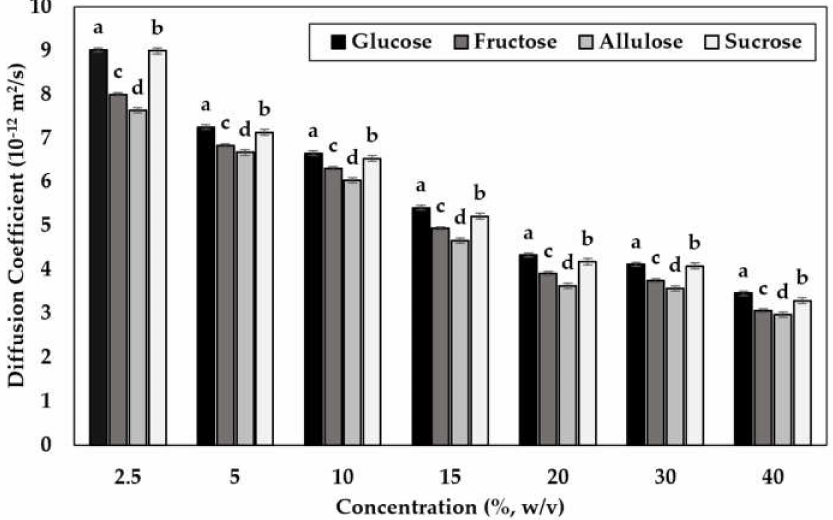
Figure 3. Self-diffusion coefficient of water in sugar solutions at different concentrations (%) obtained from Stimulated Echo Sequence ( w/v ). For each concentration value, lower case superscript letters (a–d) denote significant difference at 5% ( p < 0.05). Values are expressed as mean ± SE ( n =